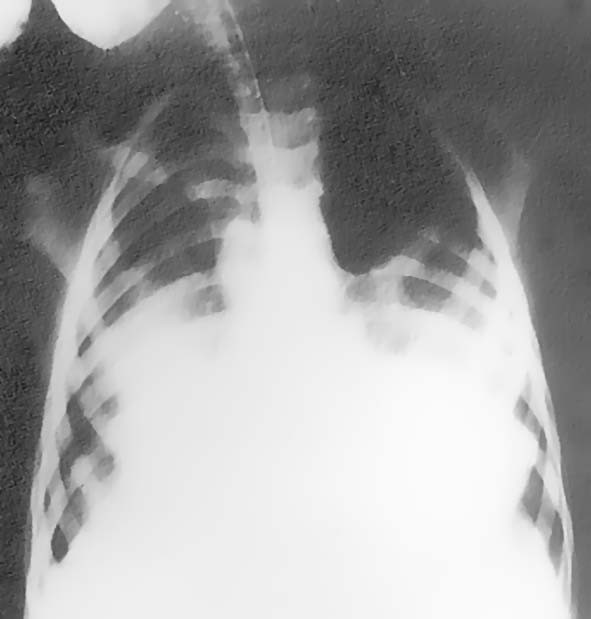
Chest roentgenogram upon admission. Frontal chest roentgenogram revealed extensive bilateral diffuse pulmonary infiltrations, left greater than right.